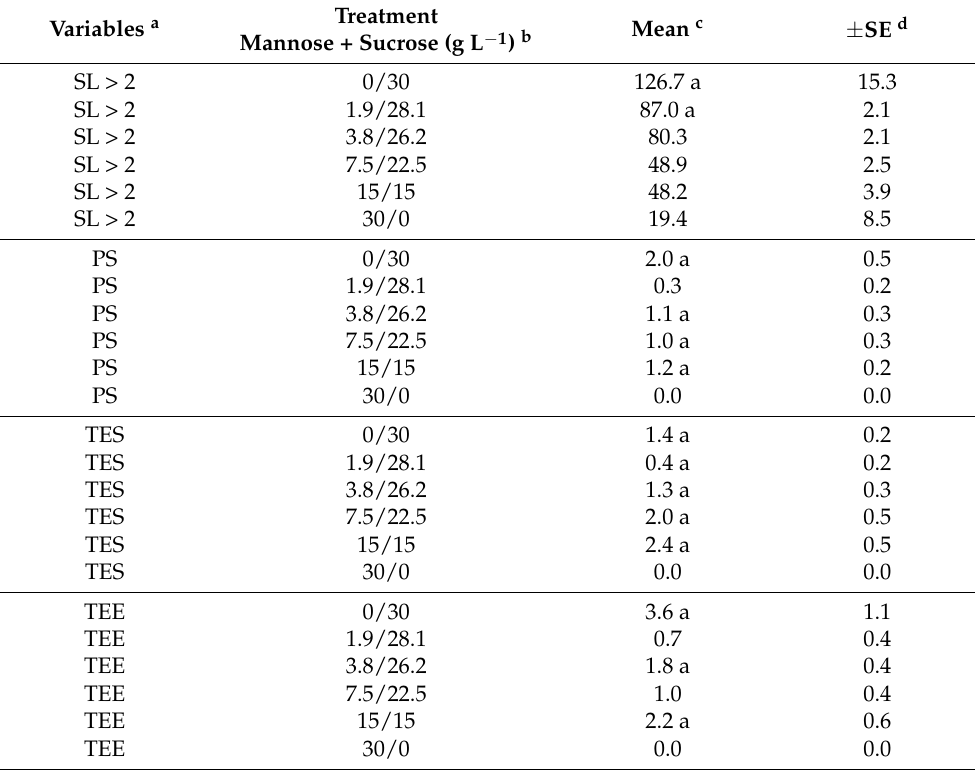
Table 2. AtPMI2 means, multiple comparisons, and standard errors for the different variables. Variables